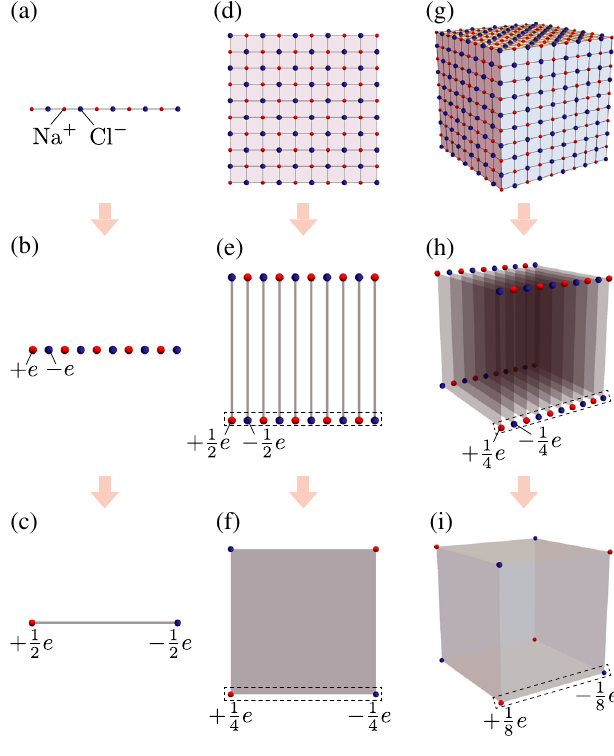
FIG. 2. Understanding of the fractional corner charges from the coupled-wire/layer construction. (a) – (c) The wire of NaCl ex- hibits (cid:1) e= 2 charges at ends as a result of the polarization þ e= 2 . (d) – (f) The monolayer of NaCl may be regarded as a periodic array of NaCl wires. The end charges (cid:1) e= 2 in the gray dashed box can be regarded as the 1D system illustrated in (a). They produce the (cid:1) e= 4 corner charge of the monolayer. (g) – (i) Sim- ilarly, the cubic crystal of NaCl may be regarded as a periodic array of NaCl layers. The corner charges (cid:1) e= 4 in the gray dashed box can be regarded as the 1D system illustrated in (a). They produce the (cid:1) e= 8 corner charge of the cubic